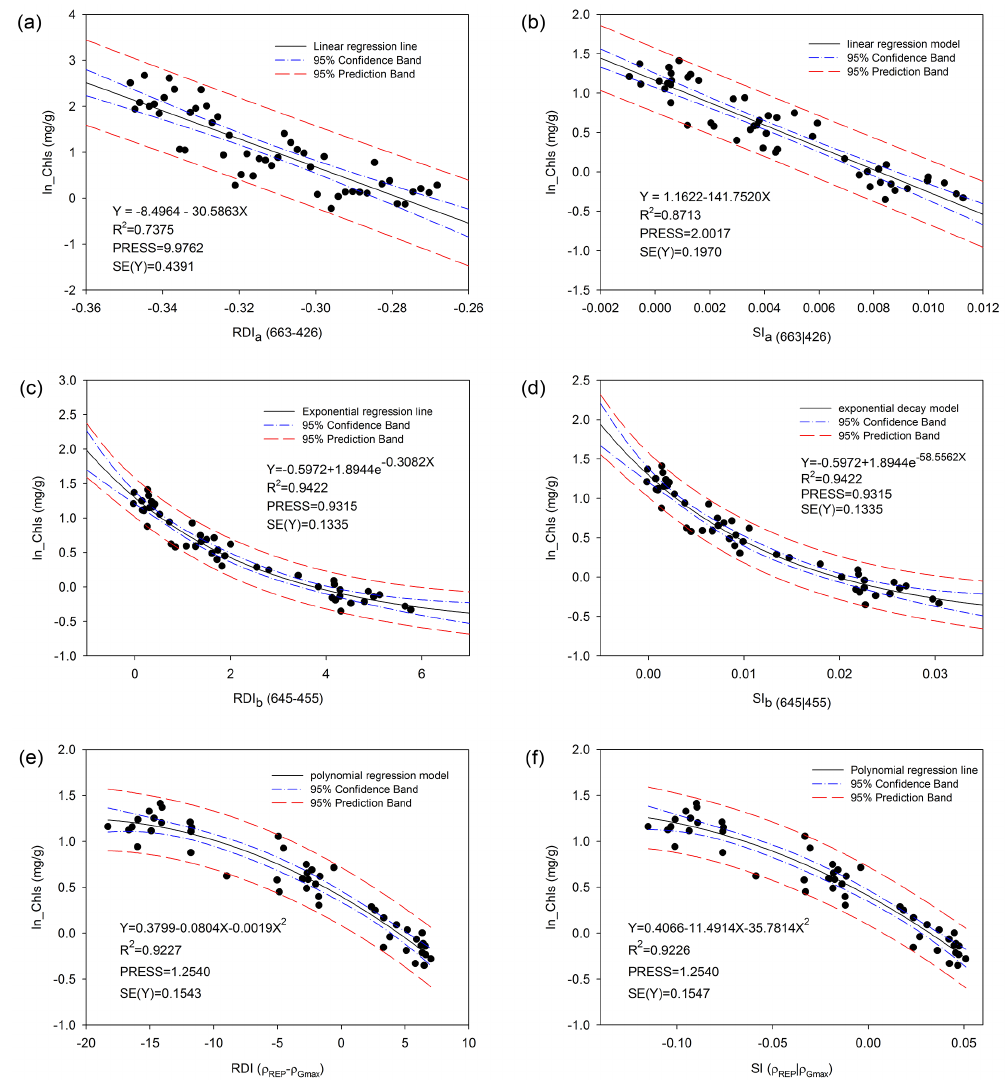
Figure 5. RDI- and SI-based empirical models for the estimation of foliar total chlorophyll